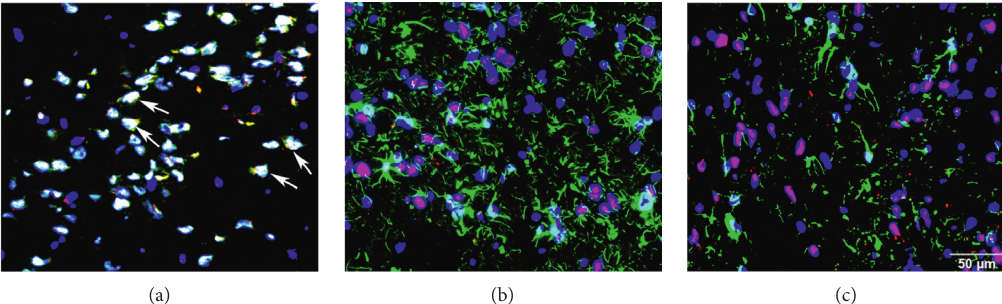
Figure 2: Localization of SIRT1 in the VTA of mice. Double immunofluorescent staining for SIRT1 (red) and NeuN (green), GFAP (green), or Iba-1 (green) was employed to identify the location of SIRT1 in the VTA. The nucleus was counterstained with DAPI (blue). Colocalization of SIRT1 and NeuN denotes that SIRT1 localizes in the nuclei of the neurons (white arrows). Scale bar � 50 μ m. (a) SIRT1/ NeuN. (b) SIRT1/GFAP. (c)